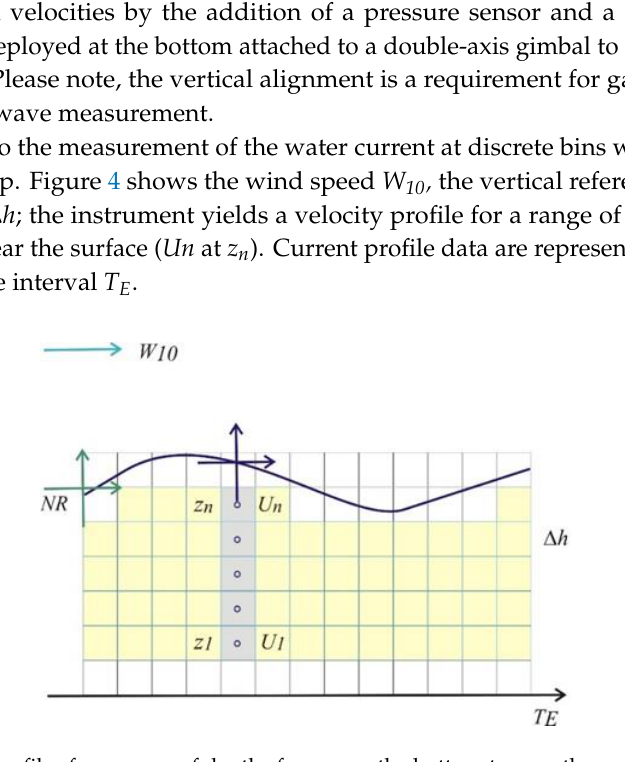
Figure 4. Current profiles for a range of depths from near the bottom to near the surface; the shallower ADCP layer and the wind sensor reference height depends on tidal variation.